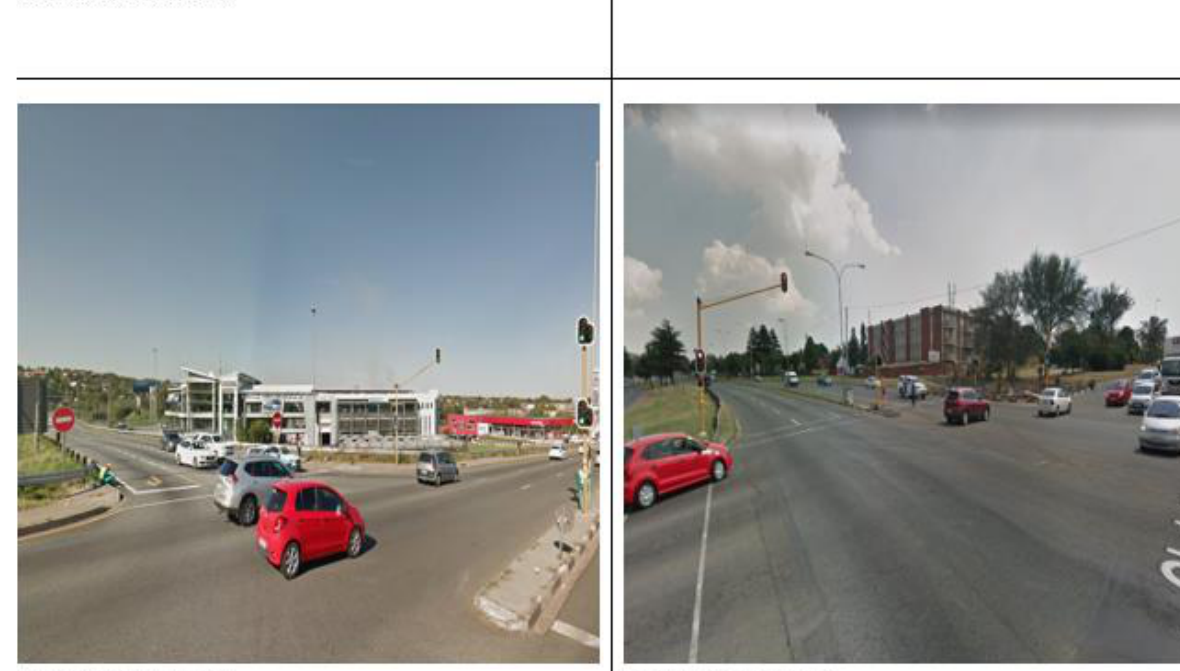
Figure 3. Location of traffic data collection ( a – d ).